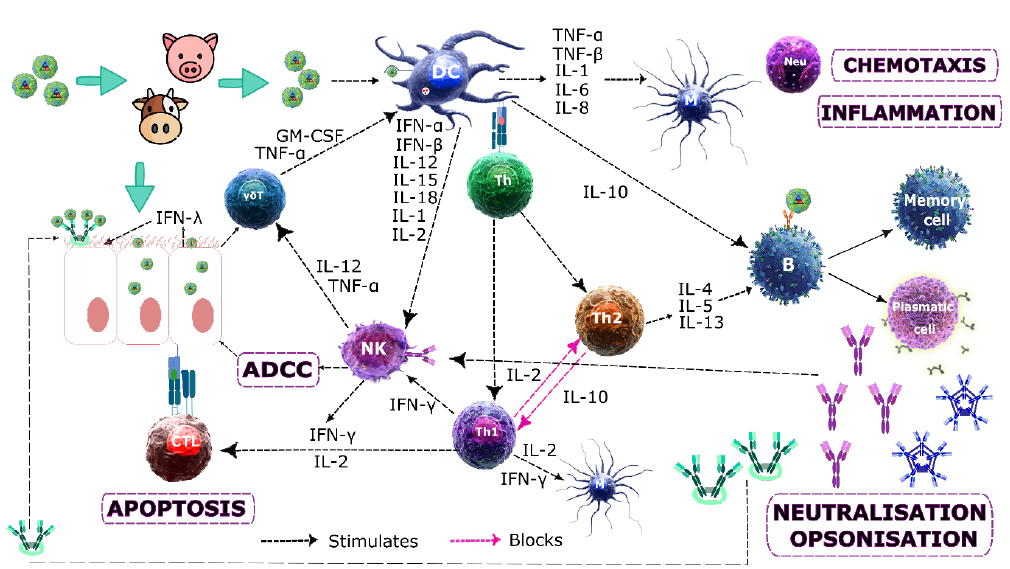
Figure 3. Ideal host immune response to FMDV. Anatomical, physiological, endocytic, phagocytic, and inflammatory barriers initially react against FMDV: the mucosity produced by respiratory tract ciliated cells retain part of the viral particles; neutrophils (Neu), eosinophils, dendritic cells (DC), macrophages (M), and cytotoxic (CTL) and natural killer (NK) lymphocytes, complement proteins and other inflammation mediators begin to act. Stress signals trigger gdT in tissue to secrete cytokines, thereby attracting DCs, macrophages and B-lymphocytes which act as antigen-presenting cells (APC). A greater amount of DCs and macrophages phagocyte FMDV, process it and express the antigens on its membrane with major histocompatibility complex (MHC) intervention, these being recognized by Th-lymphocytes, giving rise to Th1 and Th2 differentiation. The cytokines secreted by these cells stimulate macrophage, neutrophil, DC, natural killer cell, CTL, and B-lymphocyte proliferation and differentiation. The virus’ soluble antigens (SA) bind to B-cell Abs simultaneously with antigen presentation by antigen-presenting cells; this is followed by these cells becoming transformed into plasma cells secreting IgM, IgG, and IgA, where IgM and IgG opsonize viral particles, stimulating phagocytosis, neutralising and activating antibody-dependent cellular cytotoxicity (ADCC), whilst IgA contributes to retaining viral particles in the mucosa, avoiding infection of epithelial cells. Infected target cells also express viral proteins from their cytosol along with MHC class I intervention and CTL are recognized, enabling Th1 stimulus to induce infected cell apoptosis. Antigen binding to B- and T-lymphocyte receptors triggers their activation; this is mediated by a complex cytokine network (interleukins (IL), tumor necrosis factors (TNF), interferons (IFN), colony-stimulating factors (CSF) and chemokines) connecting cells to each other, regulating their function by inducing or supressing their synthesis or that of other cytokines and their receptors. Activated lymphocytes multiply by clonal expansion, producing two types of cell: e ff ector and memory cells. E ff ector cells have a short lifespan and e ff ect and regulate response to a pathogen. Memory cells live for a long time, increasing immune response speed and intensity if the same pathogen is found